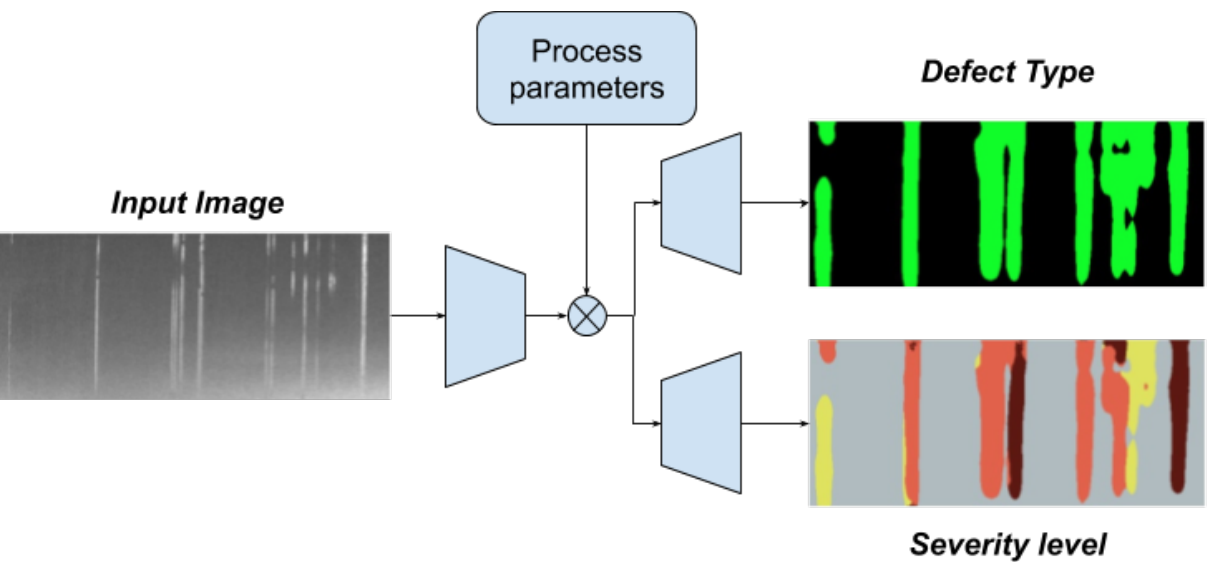
Figure 1. Overview of our approach. A multi-task model segments the input image into 16 different defect classes while also estimating a suitable pixel-based severity level. To enhance the segmentation performance, additional steel production process parameters are fed into the